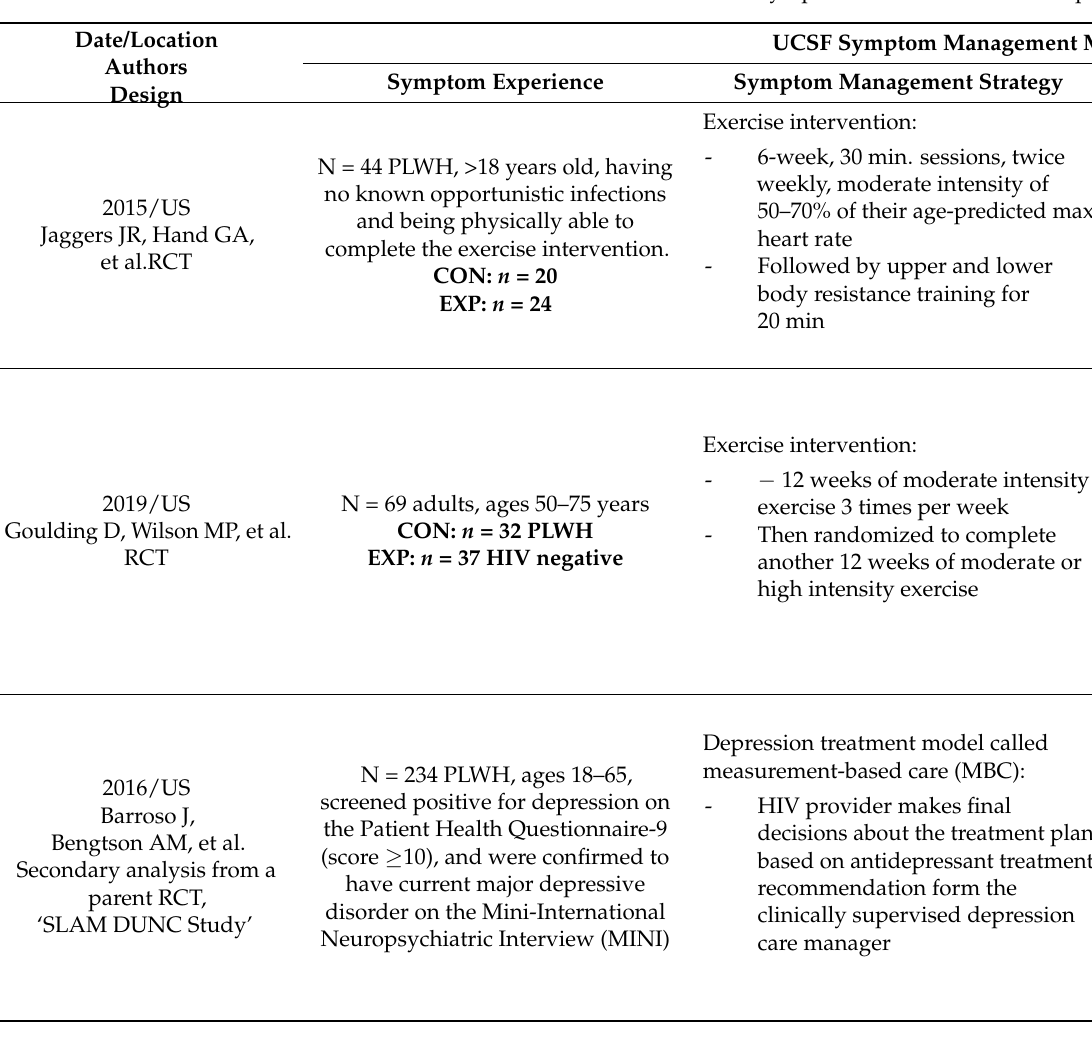
Table 1. Nurse-led Symptom Science Studies on Improving Fatigue in